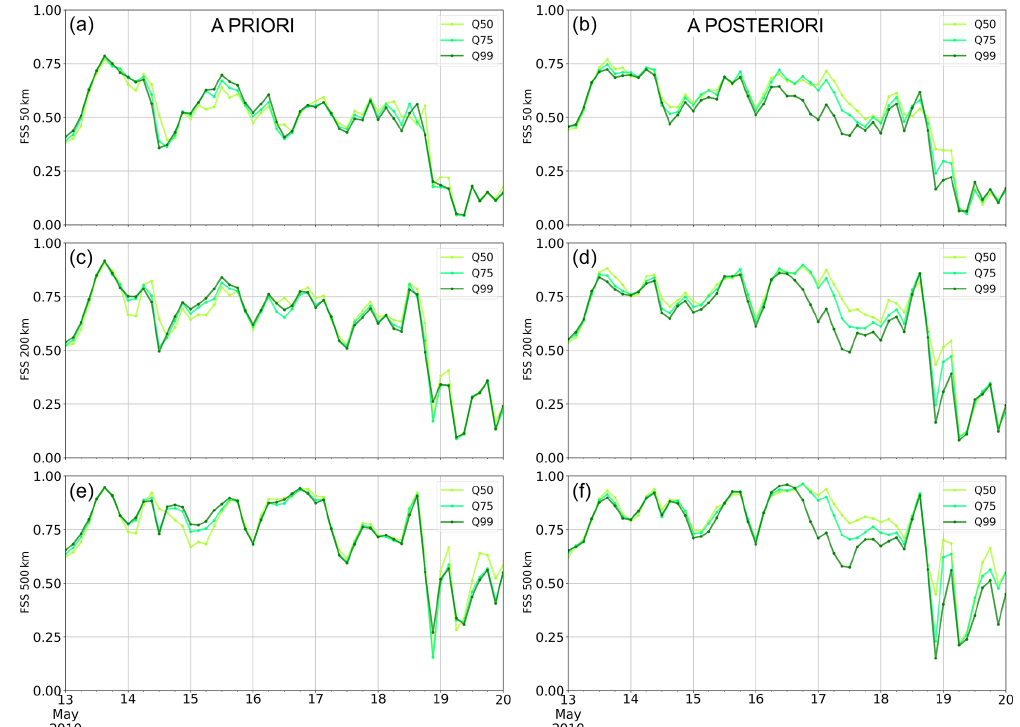
Figure 8. Comparison of the fraction skill score (FSS) of ash column locations, for the ensemble quantile median ( Q 50), 75th percentile ( Q 75), and 99th percentile ( Q 99) with a priori source terms (a, c, e) and with a posteriori source terms (b, d, f) . The FSS values are shown for radii of 50 (a, b) , 200 (c, d) , and 500km (e, f) .